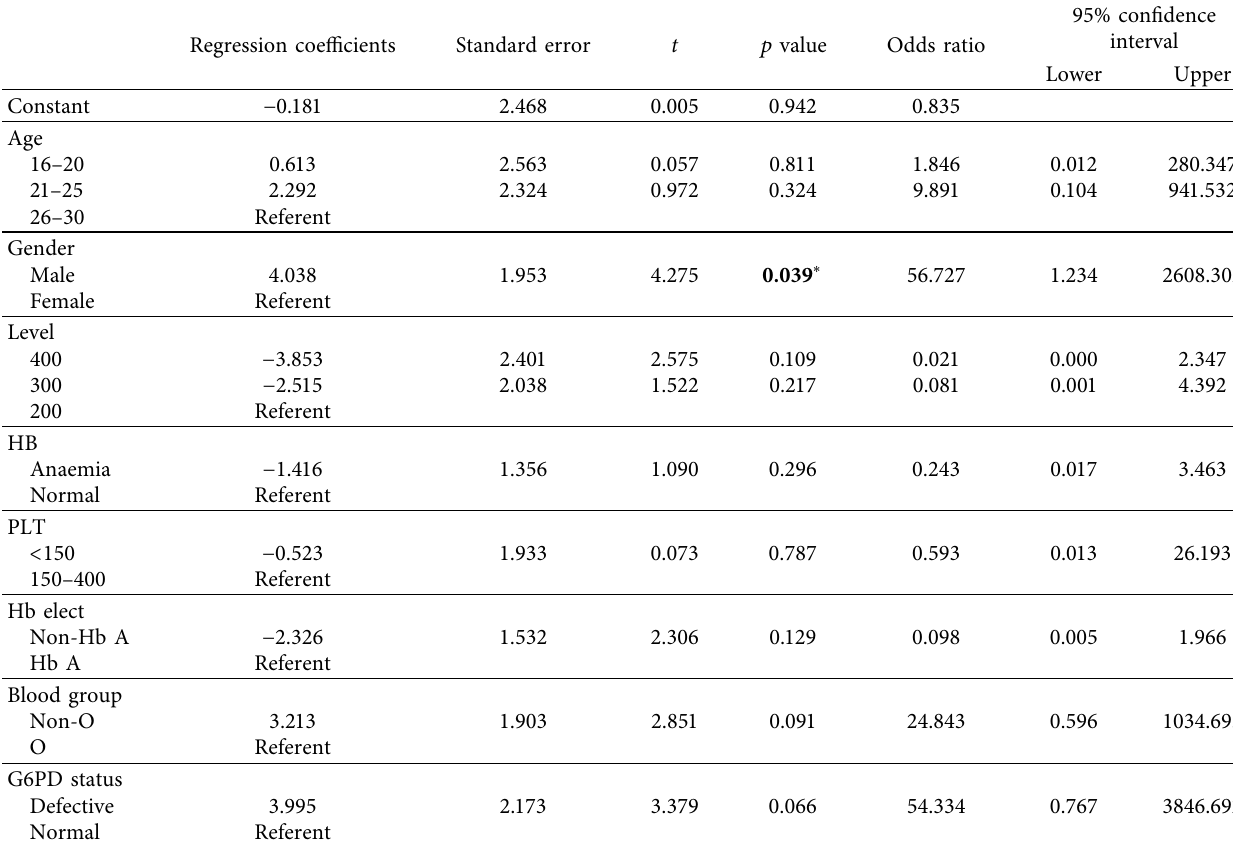
Table 3: Factors associated with optimal iron levels (ferritin ≥